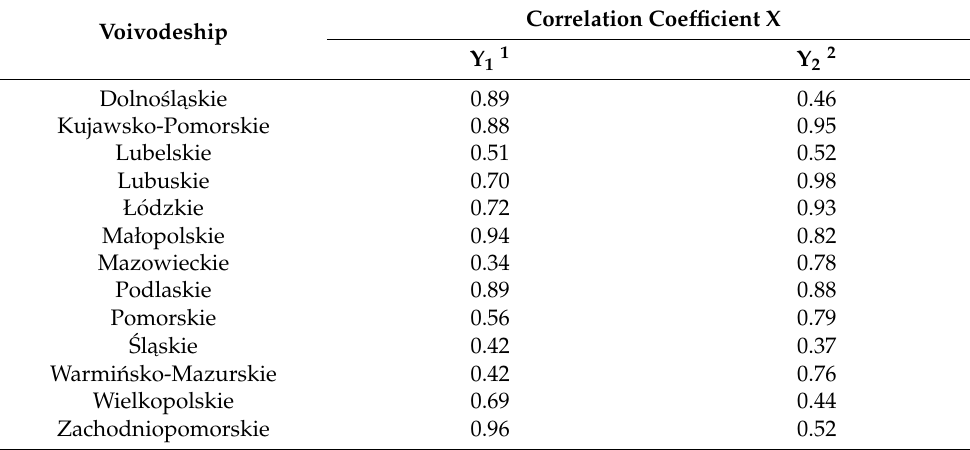
Table 13. Values of the correlation coefficient for the increase in the length of sewage networks and the size of the degraded and revitalisation